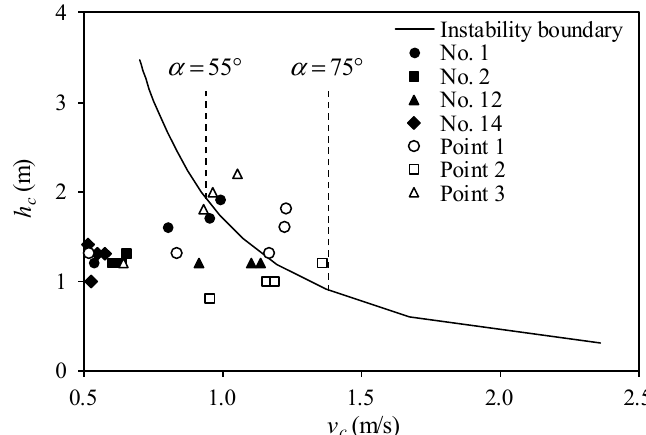
Figure 10. Plots of the instability boundary against to inundation depth and runoff velocity.